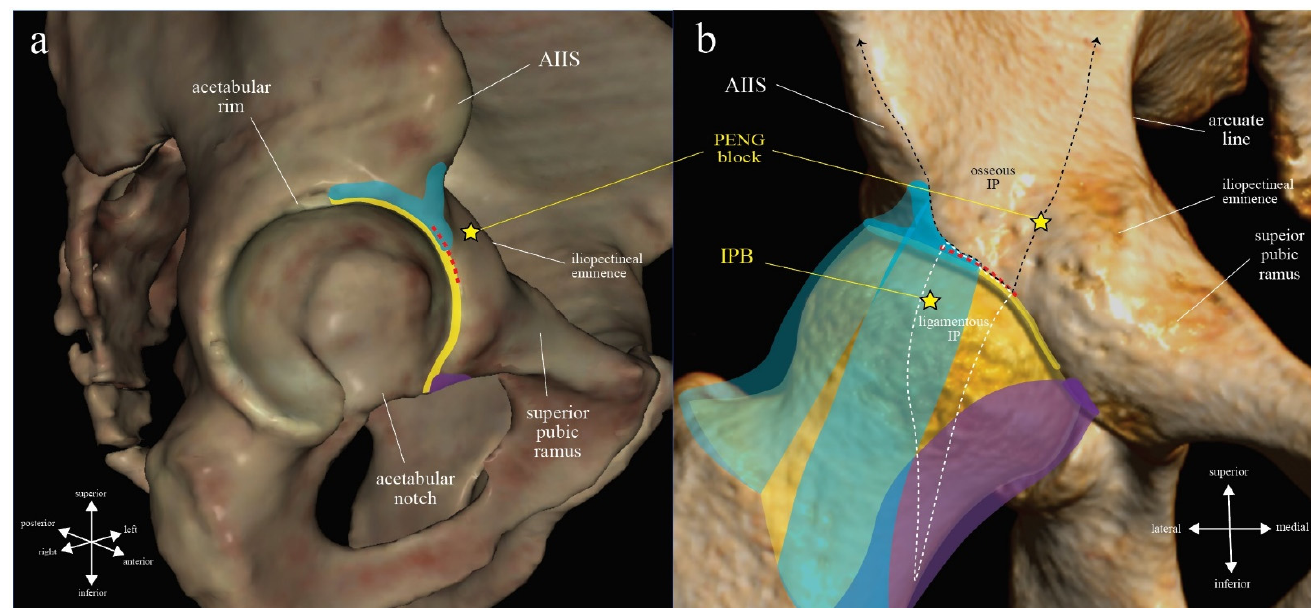
Figure 2. Capsular ligaments of hip of the anterior hip capsule and distinction of the osseous and ligamentous iliopsoas plane (IP): (a) Lateral view of the right-sided acetabulum, with femur re- moved, is shown here to demonstrate the proximal attachments of the capsular ligaments of hip of anterior hip capsule and their spatial relationship to the acetabulum and its surrounding iliopubic structures. The attachments of iliofemoral ligament, the capsular fibers, and pubofemoral ligament to the acetabular rim are colored in blue, yellow, and purple, respectively. Both iliofemoral ligament and pubofemoral ligament are distinct thickening of the capsular fibers. The Figure was modified from a reconstructed cadaveric image by the Visible Human Project® of National Library of Medi- cine acquired from the VH Dissector with permission from Touch of Life Technologies Inc (www.toltech.net, accessed on 20 July 2022); (b) In this three-dimensional computed tomography image of the right-sided hip joint reconstructed from a real patient with volume-rendering tech- nique, the osseous IP refers to the wide shallow groove between anterior inferior iliac spine (AIIS) and iliopectineal eminence and its cranial extension on ilium, as demarcated by the arrowed dashed black line. Iliopsoas valley, marked as the dashed red line (also in Figure 2a), is a depression of the anterior acetabular rim that is continuous with the AIIS-iliopectineal eminence concave to allow passage of the iliopsoas complex inferiorly over the femoral head. Capsular ligaments of hip are illustrated as colored bands connecting the acetabular rim and the intertrochanteric line of femur, with the same colors coded as in Figure 2a. The blue-colored iliofemoral ligament has a transverse (lateral) part and a descending (medial) part. The ligamentous IP is demarcated by the dashed white line and refers to the fascial plane between iliopsoas complex and fibers of the capsular ligaments of hip, with iliopsoas tendon (IT, not shown) as its medial border and iliacus minor muscle (IM, not shown) as its lateral border. The yellow stars mark the final needle tip positions of pericapsular nerve group (PENG) block and iliopsoas plane block (IPB).